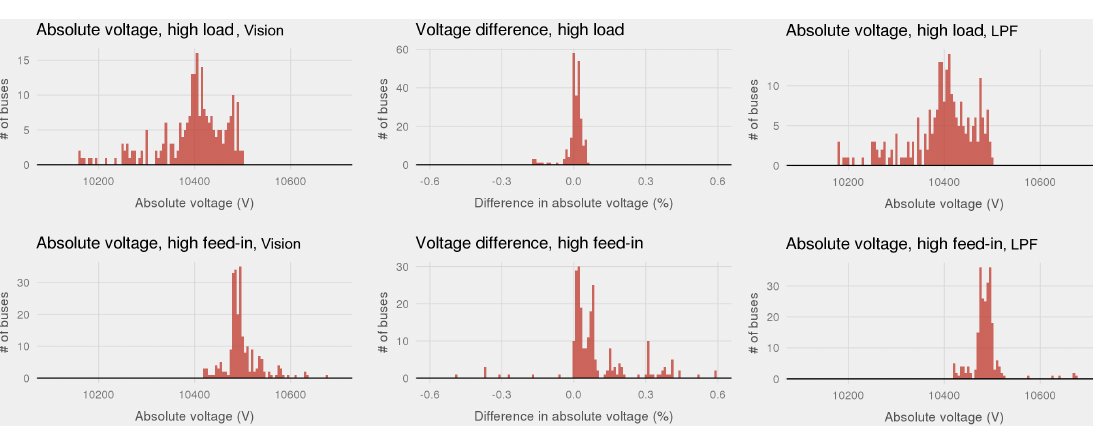
Figure 4. Histograms of the comparison between the LPF model and the commercial Vision network design tool of the network of substation Rauwerd. The left column shows a histogram of the absolute network voltages as calculated by the LPF model, showing the severity of the voltage drop in the network compared to the nominal voltage of 10,500 Volt. The right column shows the histogram of the difference in absolute voltage between results of the LPF model and